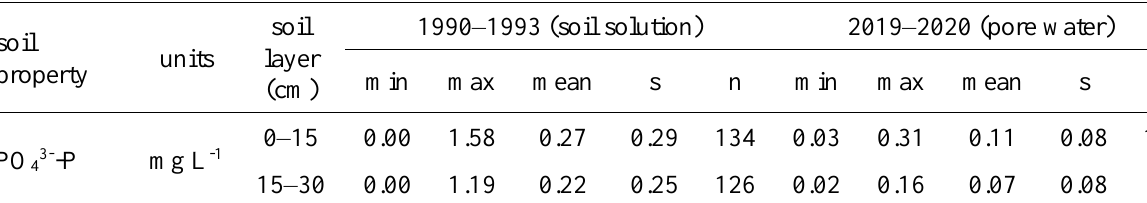
Table 3. Summary of soil water PO 43- -P concentrations from the initial examination in 1990–1993 (Gebhardt & Knabke 1994) and the follow-up examination in 2019–2020. min = minimum; max = maximum; s = standard deviation; n = sample size.